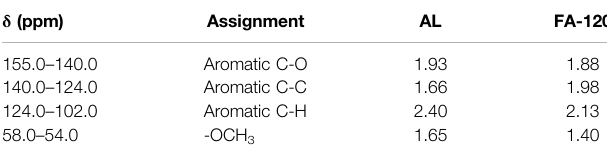
TABLE 3 | The assignment and quanti fi cation of the signals of the 13C-NMR spectra (results expressed per